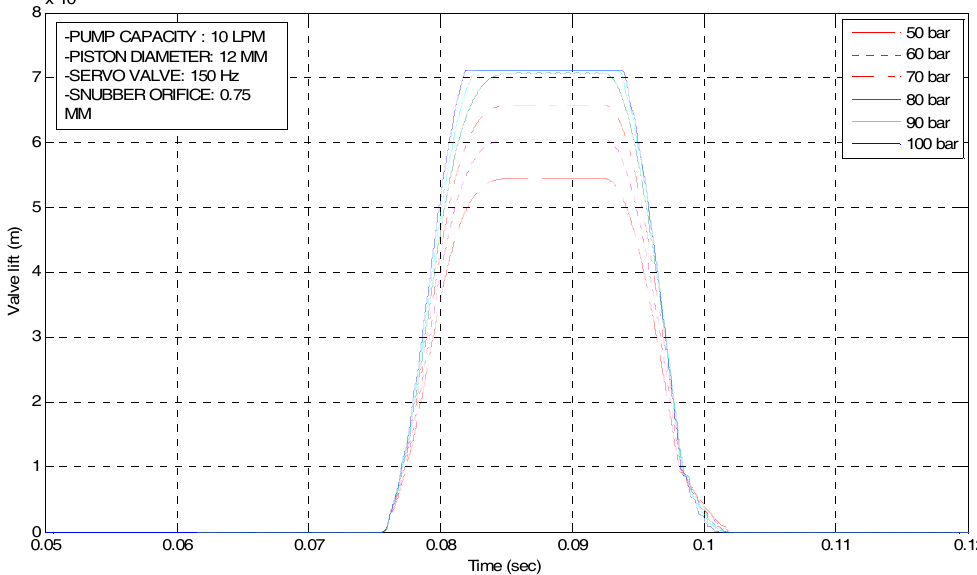
Figure 7. Simulation results for design parameter (e.g., oil supply pressure) variation.